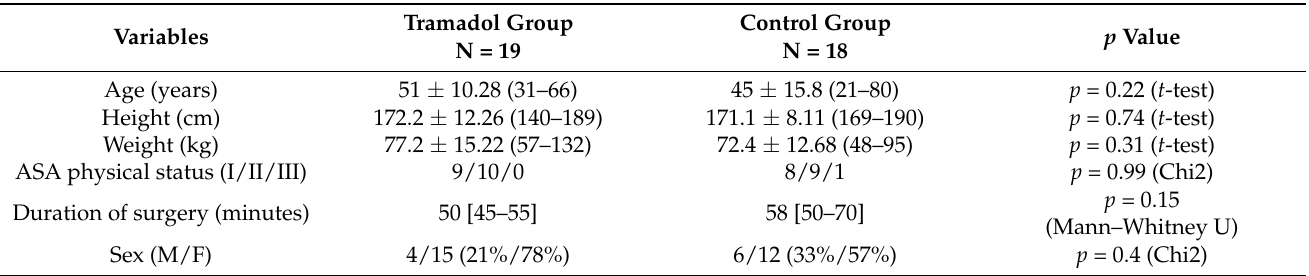
Table 1. Basic demographic characteristics.